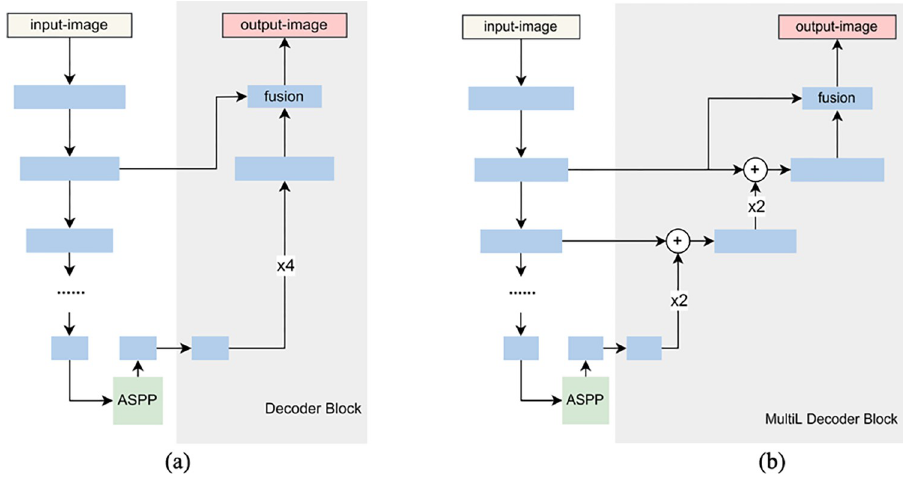
Fig 3. Comparison of the decoder block of Deeplabv3+ and EMNet. (a) Deeplabv3+ decoding module per-forms 4-fold bilinear upsampling; (b) EMNet decoding module performs multi-level